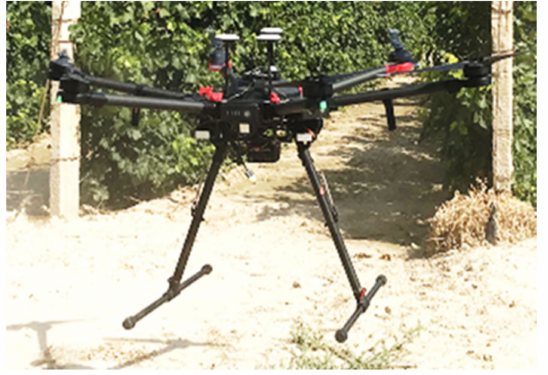
Figure 1. DJI Jingwei M600